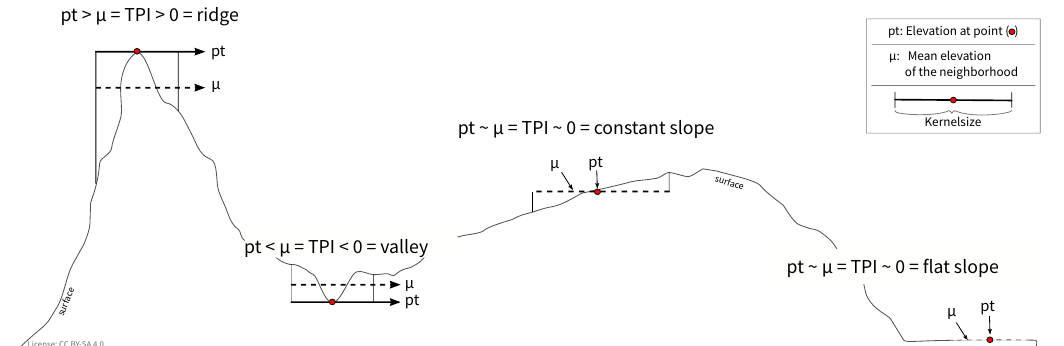
Figure 4. Principle of topographic position index (TPI). Positive TPI values are indicative of ridges or hilltops, while negative values are representative of valleys. TPI values around 0 correspond to plains or straight slopes. Landforms are sensitive to scale. Accordingly, the size of the kernel determines which topographic features are recognizable.